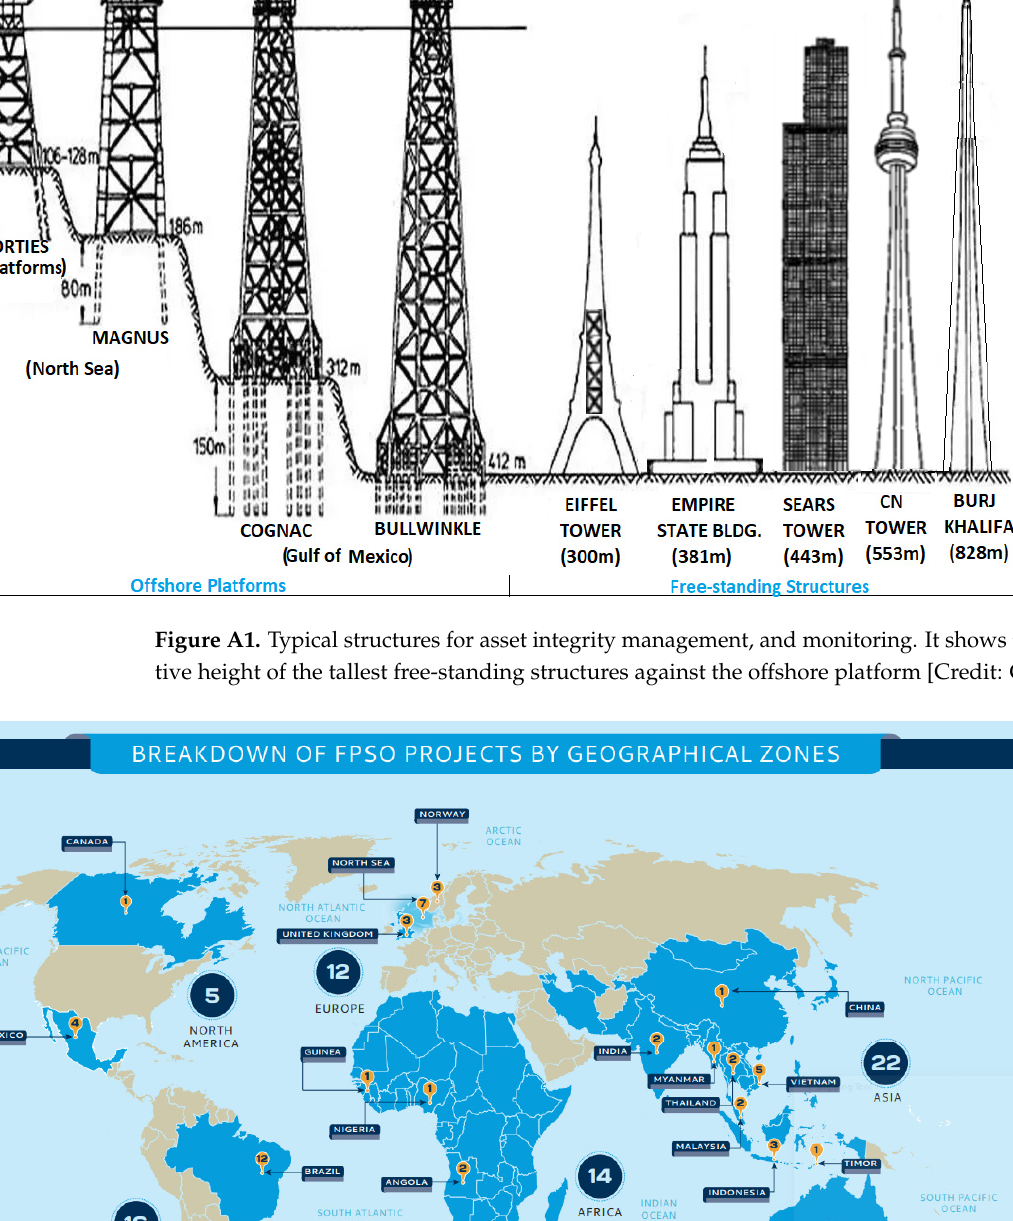
Figure A3. Map showing breakdown of projects for various assets that are located across geograph- ical zones by an oil firm on Offshore Technology .